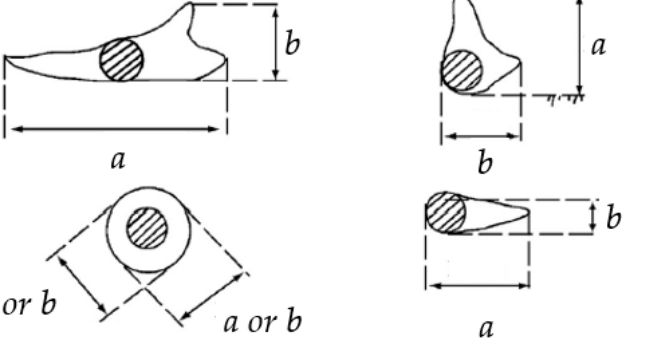
Figure 2. Sectional view of icing (shadow represents wire). Table 1. List of instruments used.